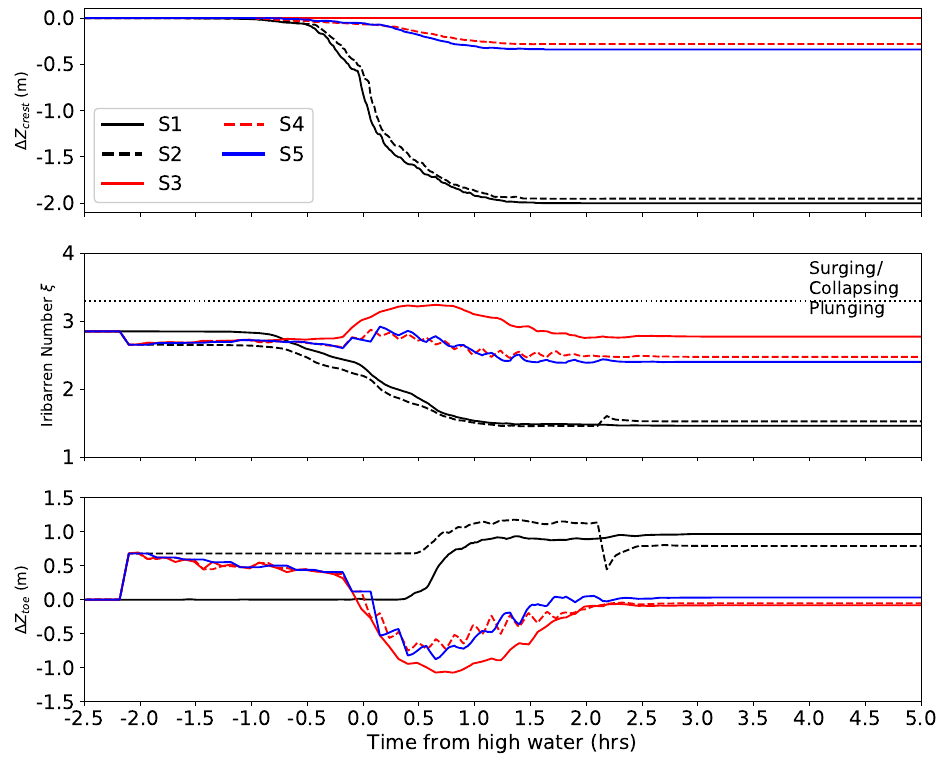
Figure 12. Changes in elevation of the barrier crest ( ∆ Z crest ), the Iribarren number ( ξ , 5min moving average) and changes in integrated elevation change in the barrier toe area ( ∆ Z toe , 5min moving average) through time, under each of the applied foreshore evolution settings. The most extreme wave percentile combination is applied, H s ,98 and T p ,98 under highest astronomical tide. The dotted horizontal line at ξ = 3.3 denotes the threshold between plunging and surging/collapsing breaking wave